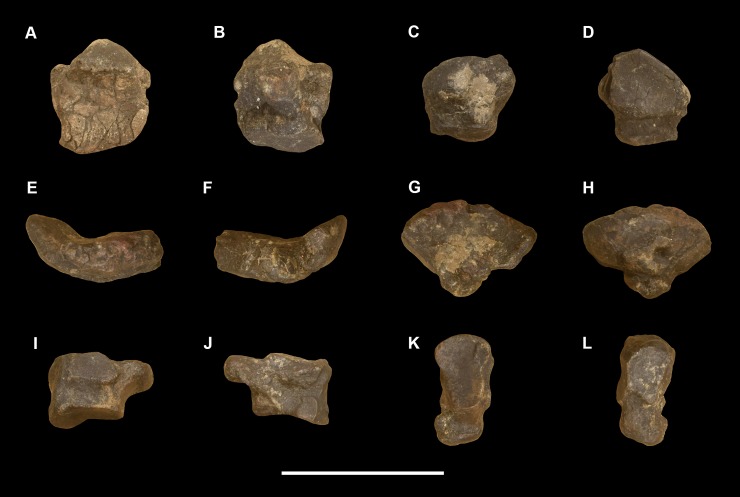
Tarsal elements of Periptychus carinidens (AMNH 3636).A-D: left cuboid: (A) dorsal view; (B) plantar view; (C) proximal view; (D) distal view. E-H: left navicular: (E) dorsal view; (F) plantar view; (G) proximal view; (H) distal view. I-L: left ectocuneiform: (I) medial view; (J) lateral view; (K) proximal view; (L) distal view. Scale bar: 30mm.